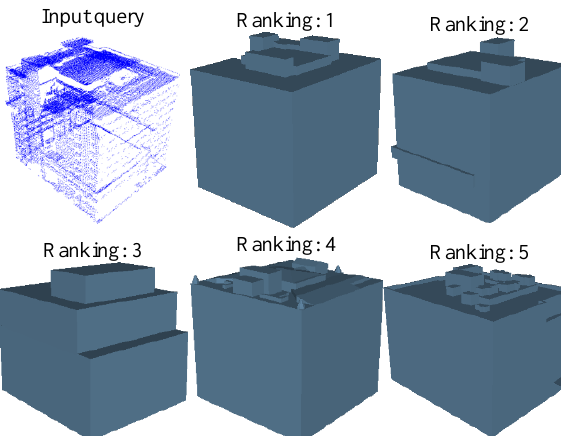
Figure 13. Retrieval results of the compared method.